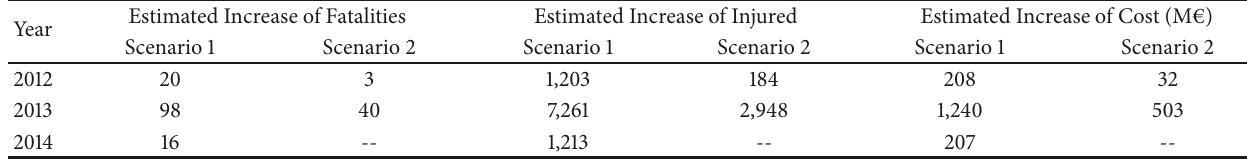
Table 4: Estimated incremental cost because of the increased Risk